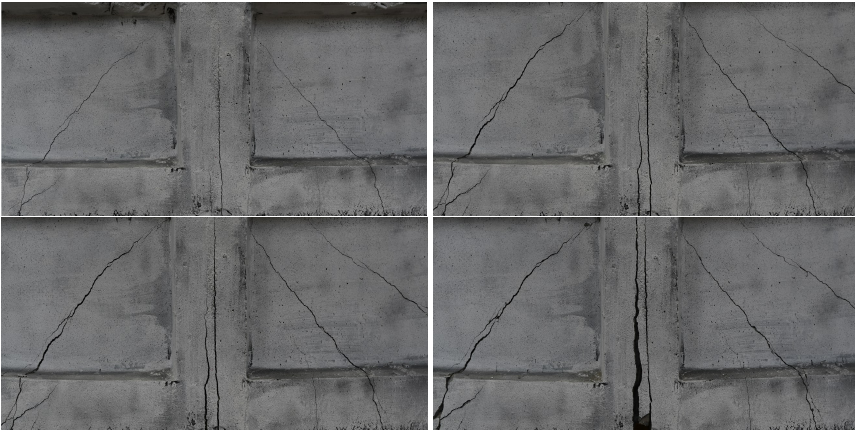
Figure 10. Images of the side surface of the beam, taken using the CivEng Vision system, during the three-point bending test.